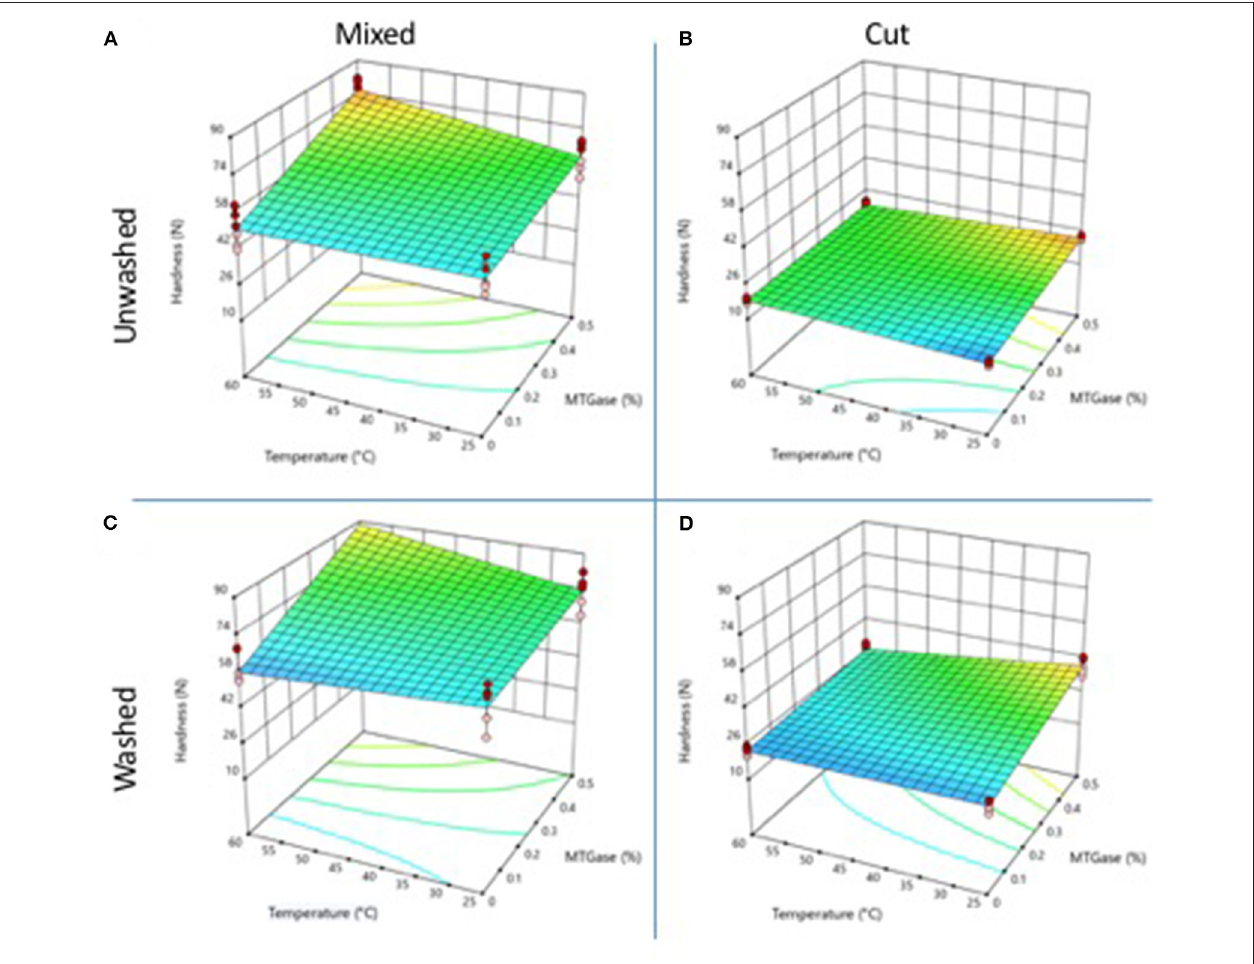
FIGURE 1 | Changes in gel hardness properties as a function of the type and temperature mixing method, washing of the cooked meat, and adding of MTGase. (A) Mixed-unwashed samples, (B) Cut-unwashed samples, (C) Mixed-washed samples, and (D) Cut-washed